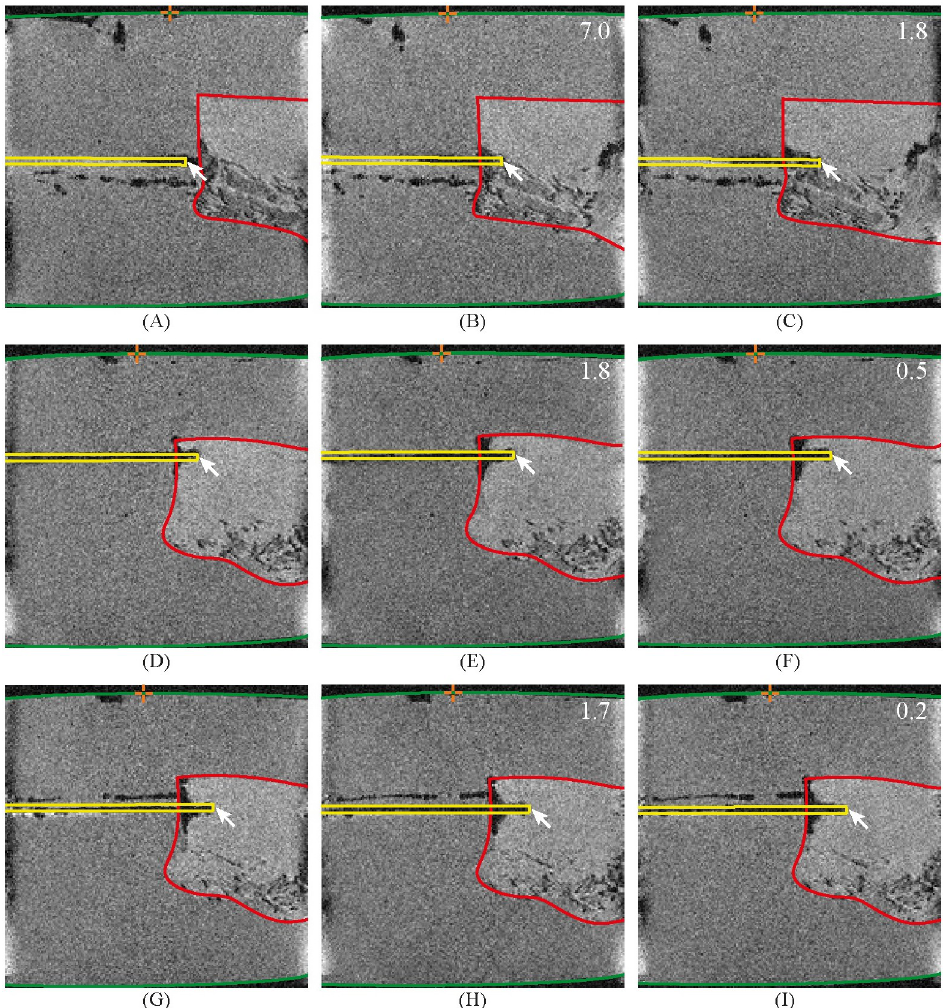
Fig 9. MR images of the needle inside the agar and ex vivo prostate tissue. Each row represents one measurement. The first column shows the initial frame where the tip is positioned inside the agar in front of the prostate tissue. The second column shows the frame after actuation over five cycles. The third column shows the frame after the second actuation over five cycles. The yellow, red, and green contours show the needle, the prostate tissue, and the tissue box sides, respectively. The arrow marks the needle tip. The orange crosshair shows the reference point on the side of the box that indicates a 40-mm insertion depth. The number in the upper right corner in black shows the measured travelled distance of the tissue box, d m , in mm, with respect to the previous MR